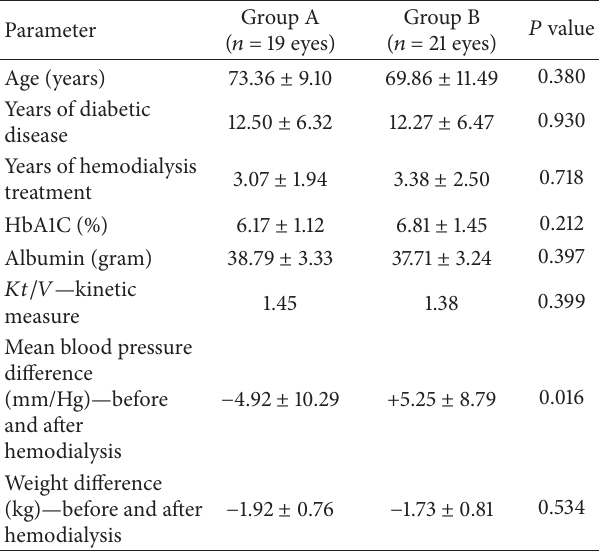
Table 3: Clinical and laboratory data for diabetic retinopathy patients with (Group A) and without (Group B) macular edema undergoing hemodialysis.